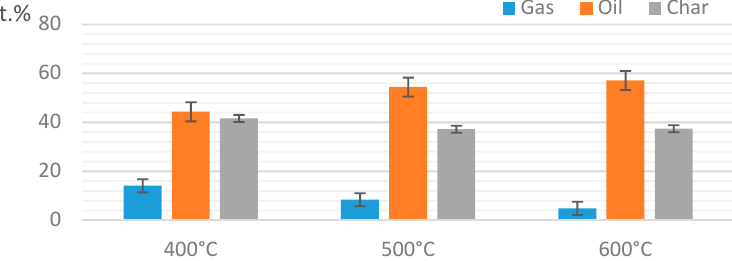
Figure 2. Gas, oil and char yields obtained at different temperatures of